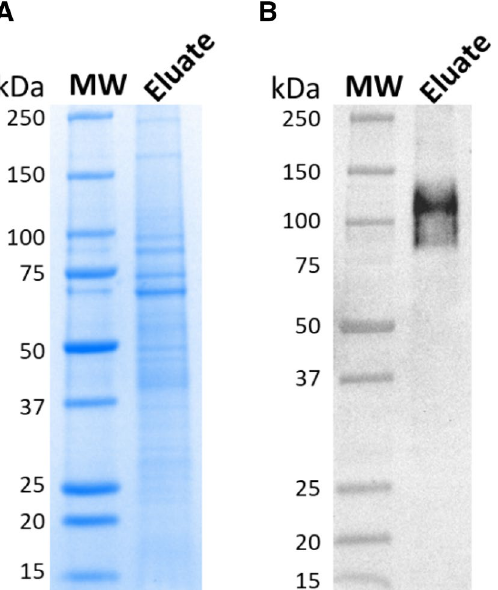
Figure 4. Analysis of immunoaffinity purified hTAS1R2. FLAG-tagged hTAS1R2 was solubilized in PBS containing 2% LMNG and captured using the EZview Red anti-FLAG M2 affinity gel. After elution with FLAG peptide, the eluate was collected, concentrated and subjected to SDS-PAGE followed by ( A ) staining with Coomassie blue and ( B ) by western blotting using mouse anti-FLAG M2 primary antibody and goat anti-mouse horseradish peroxidase conjugated secondary antibody. Full-length gels/blots are presented in Supplementary Fig.